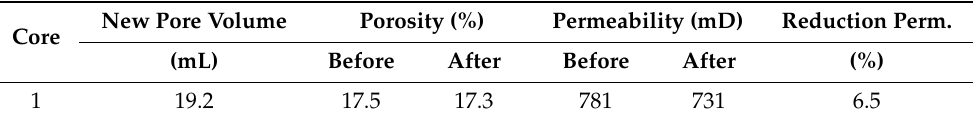
Table 9. Pore volume of core 1 after cleaning, together with permeability and porosity data before and after water flood and core cleaning.